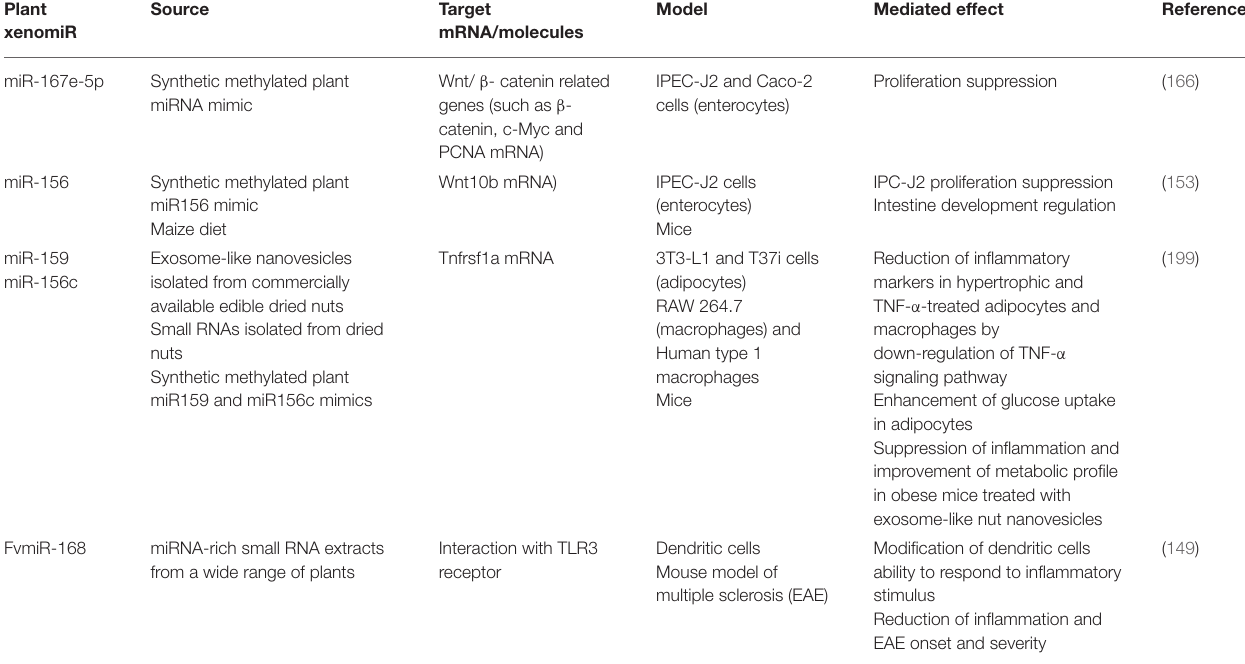
TABLE 3 | Some supporting in vitro and in vivo evidences of the interaction of plant-dietary xenomiRs with mammalian cells. Plant